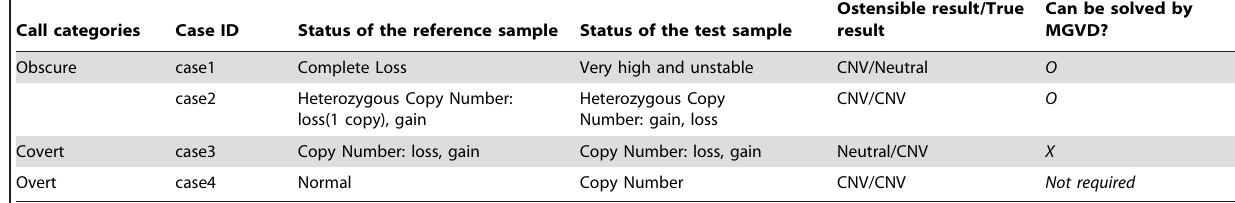
Table 5. Three categories of CNV calls proposed by [23].